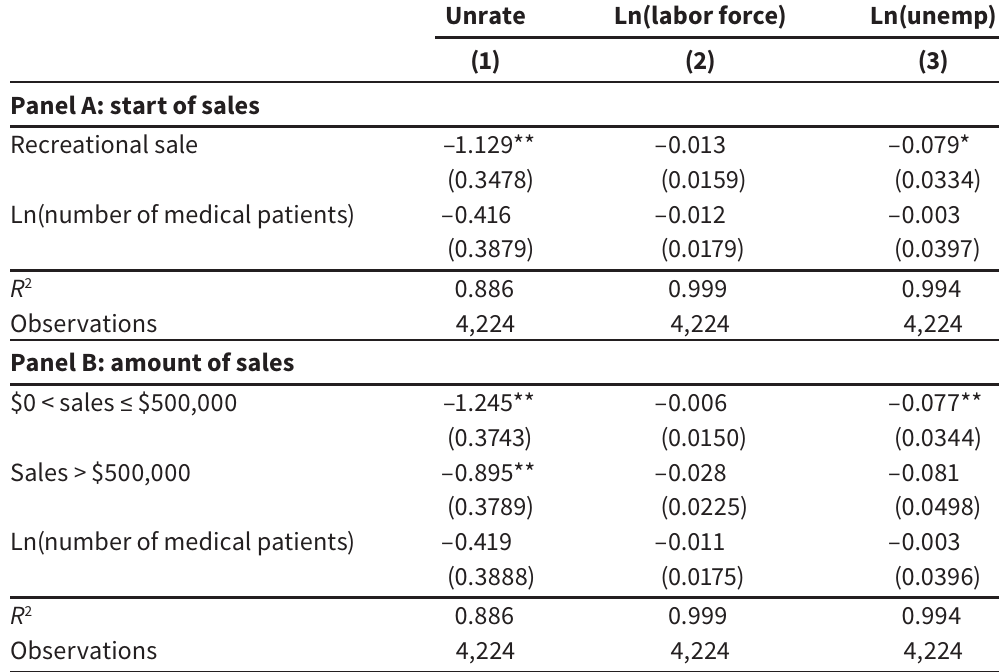
The effect of recreational dispensary entry and sales on the